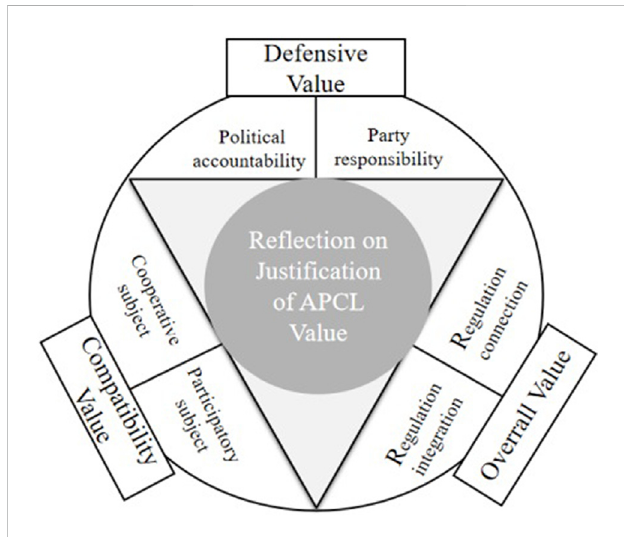
FIGURE 3 Re fl ectiion on the value legitimacy of cultivated land administrative